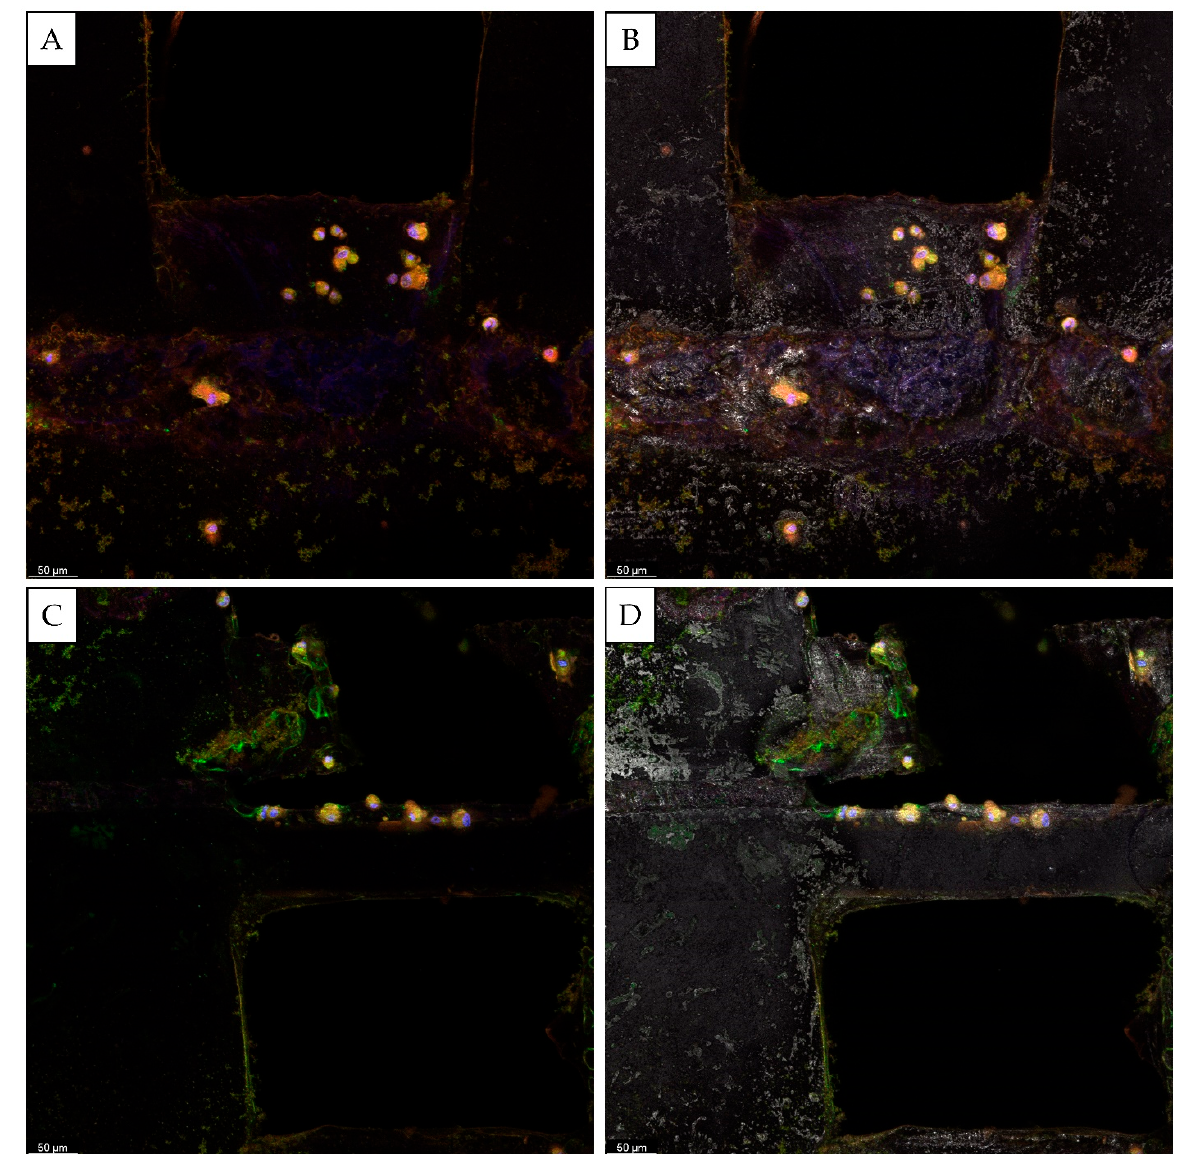
Figure 6. Confocal microscopy images of CTR scaffolds seeded with MSCs and cultured in an osteogenic medium for 28 days. Cell nuclei are stained in blue; the actin cytoskeleton is stained in red; and the mineralized matrix is stained in green ( A – D ). In ( B , D ), the material of the scaffold is evidenced in grey. Scale bar: 50 µm.